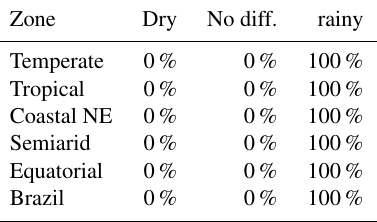
Table 6. Frequency of higher relative humidity during dry and rainy days.